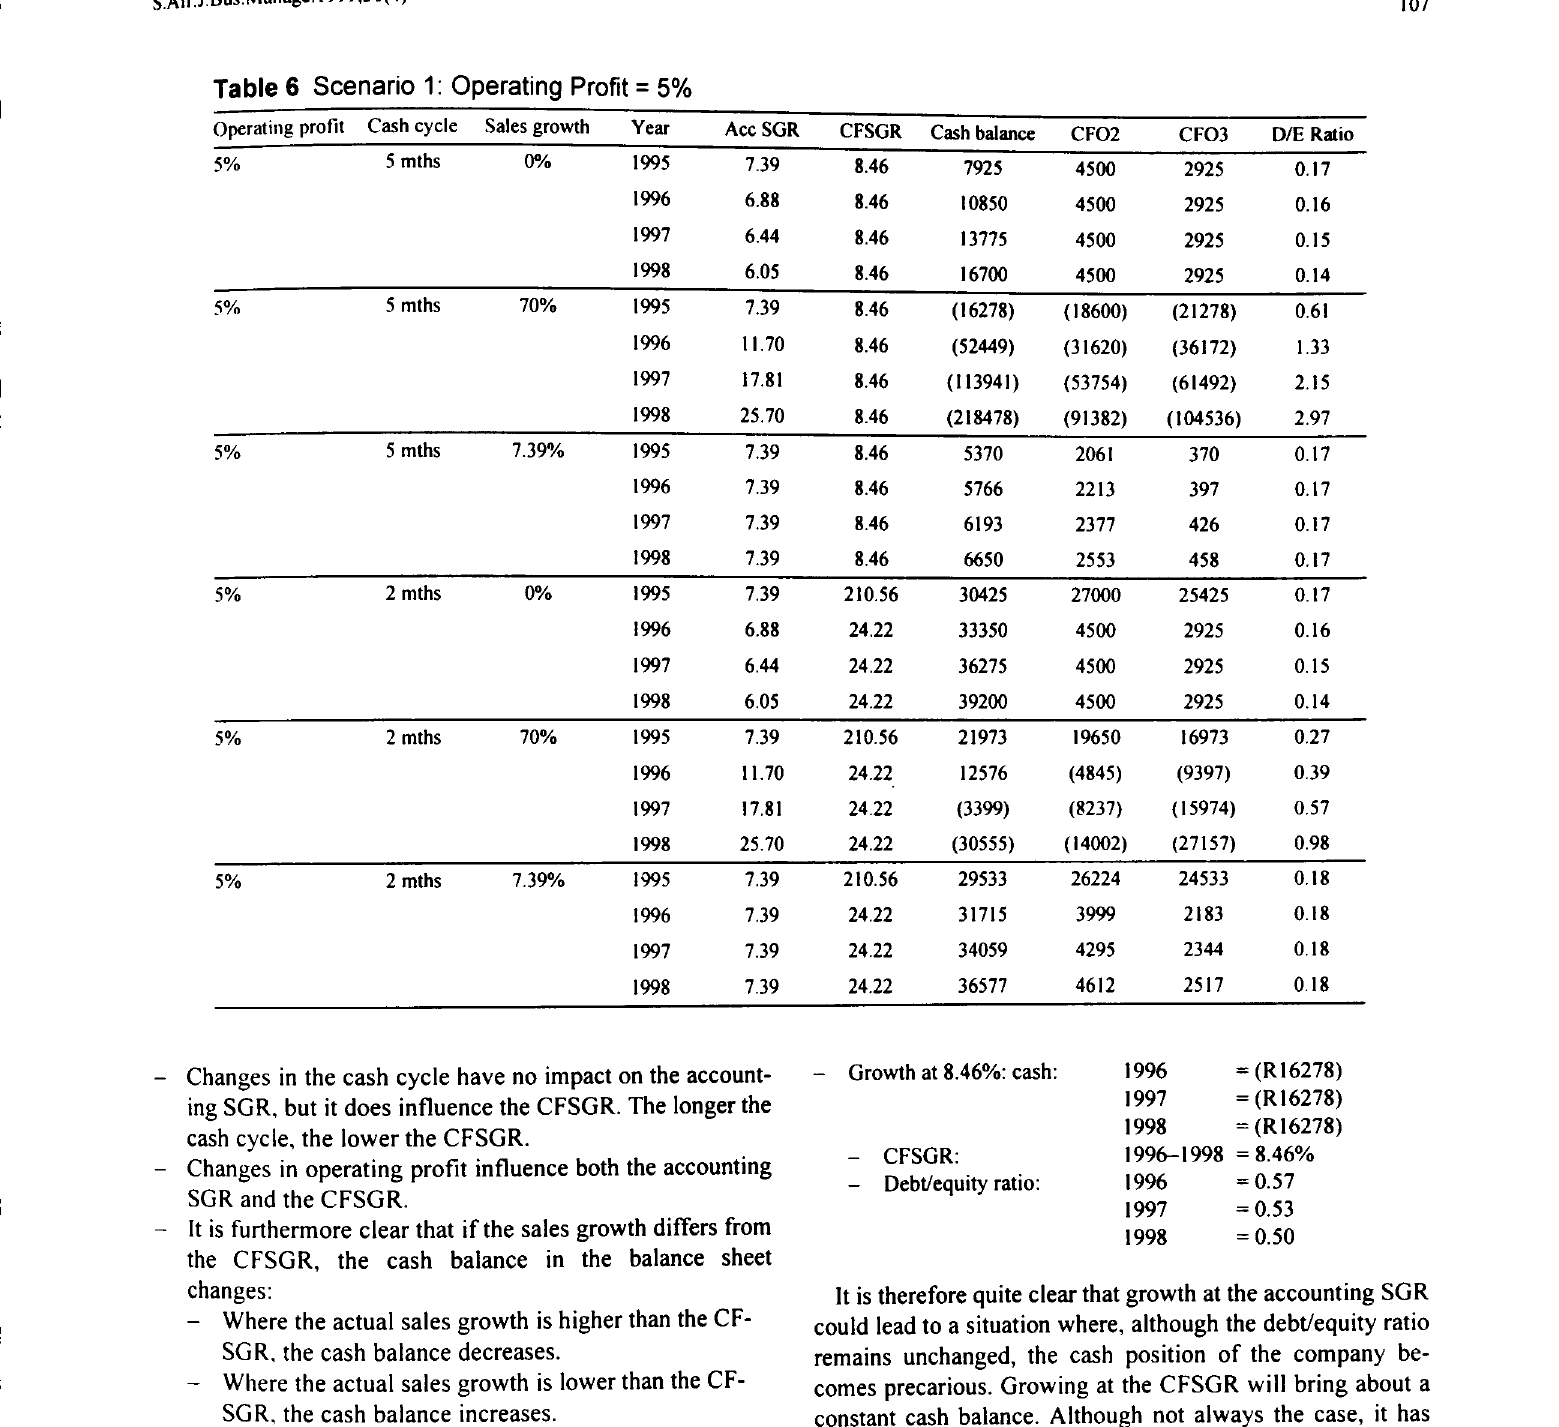
Table 6 Scenario 1: Operating Profit = 5% Operating profit Cash